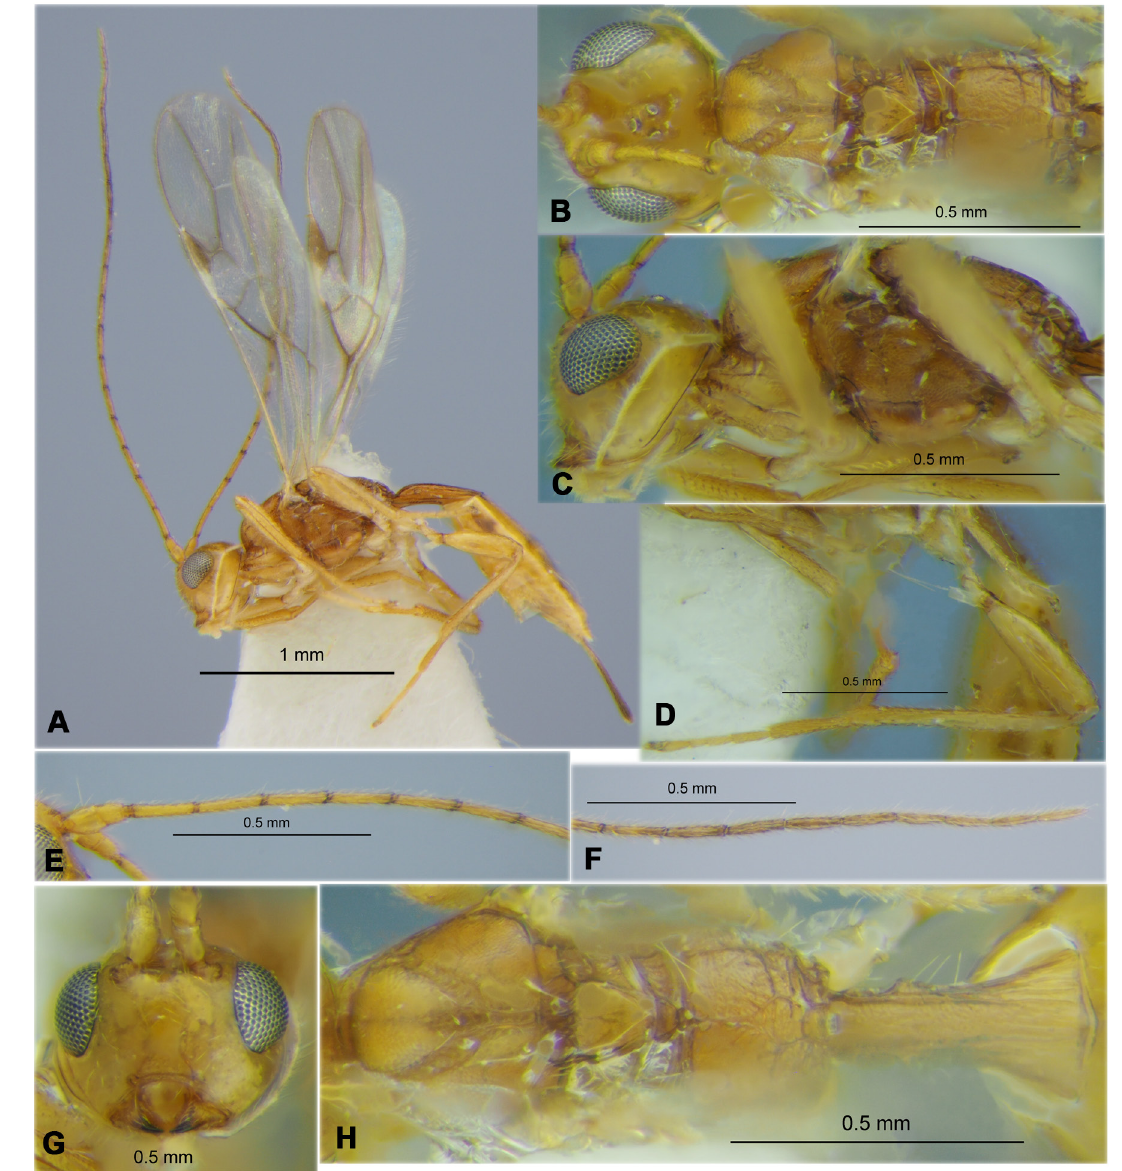
Fig. 18. Spathius austroarabicus Belokobylskij sp. nov., holotype, ♀ (RMNH). A . Habitus, lateral view. B . Head and mesosoma, dorsal view. C . Head and mesosoma, lateral view. D . Hind leg. E . Basal segments of antenna. F . Apical segments of antenna. G . Head, front view. H . Mesosoma and petiole, dorsal